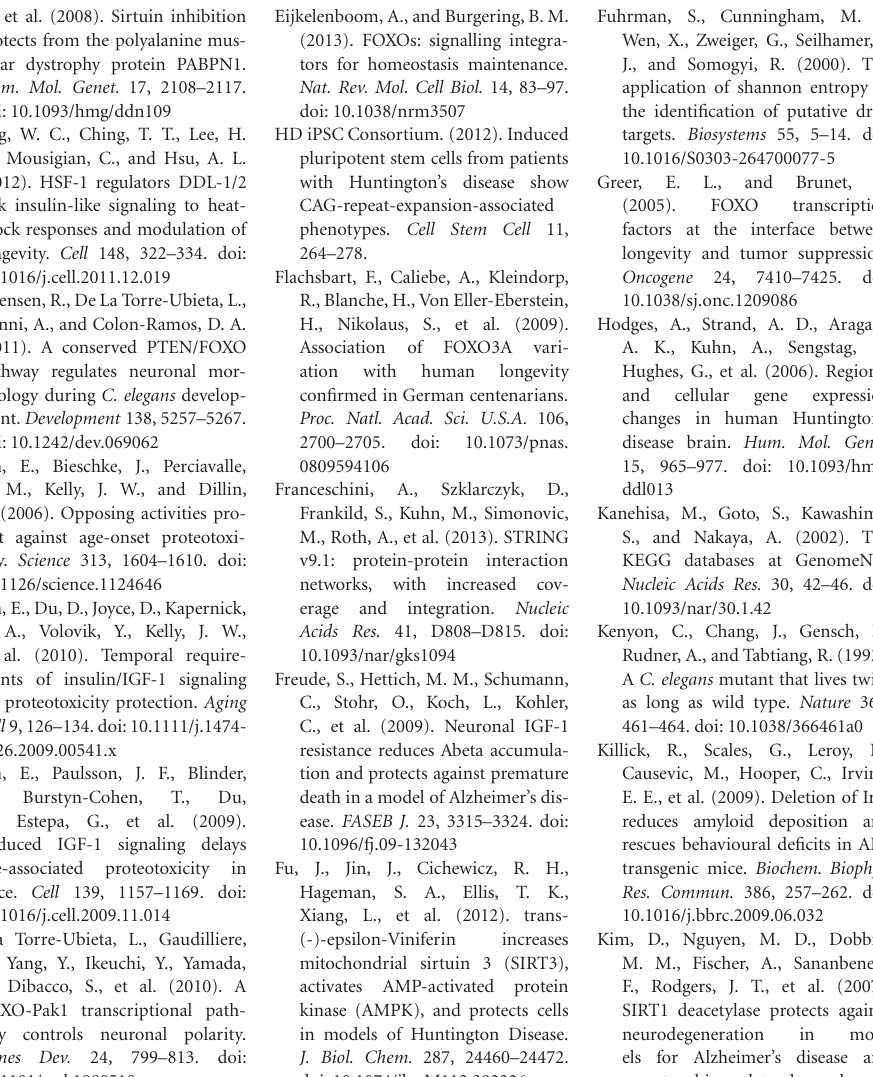
Figure S3 | Heat-map representing the biological content for low to high entropy genes in the FOXO3-interaction network and across seven mouse